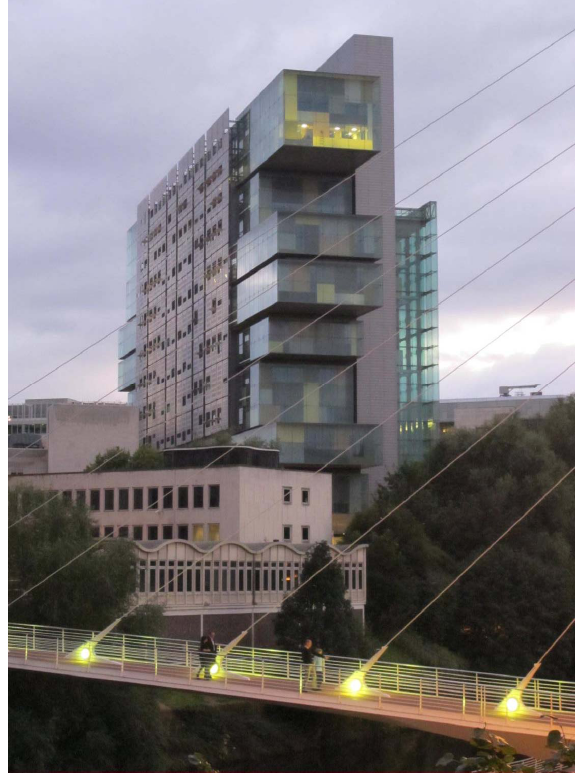
Figure 1. The Building from the North East. Atrium to the right (West), Environmental veil (East) to the left.